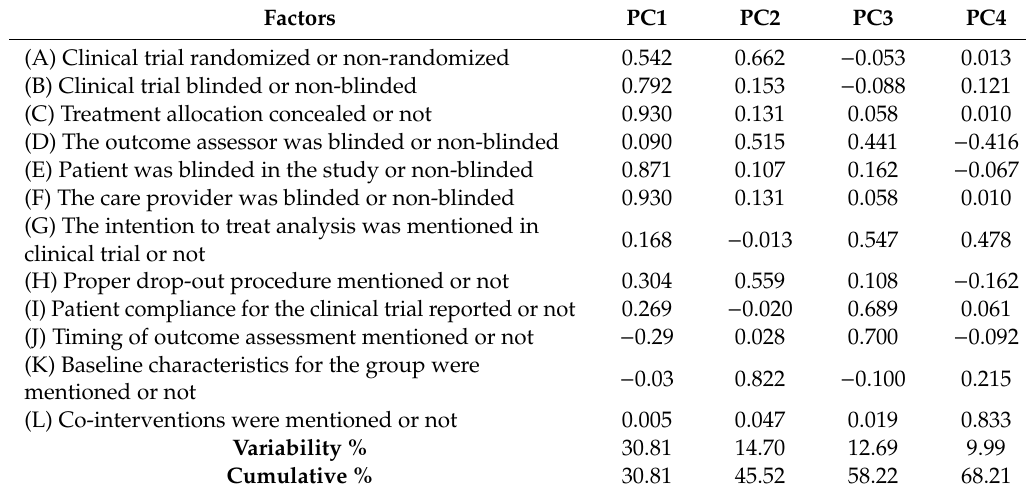
Table 5. Principal components analysis (PCA) with component loading.